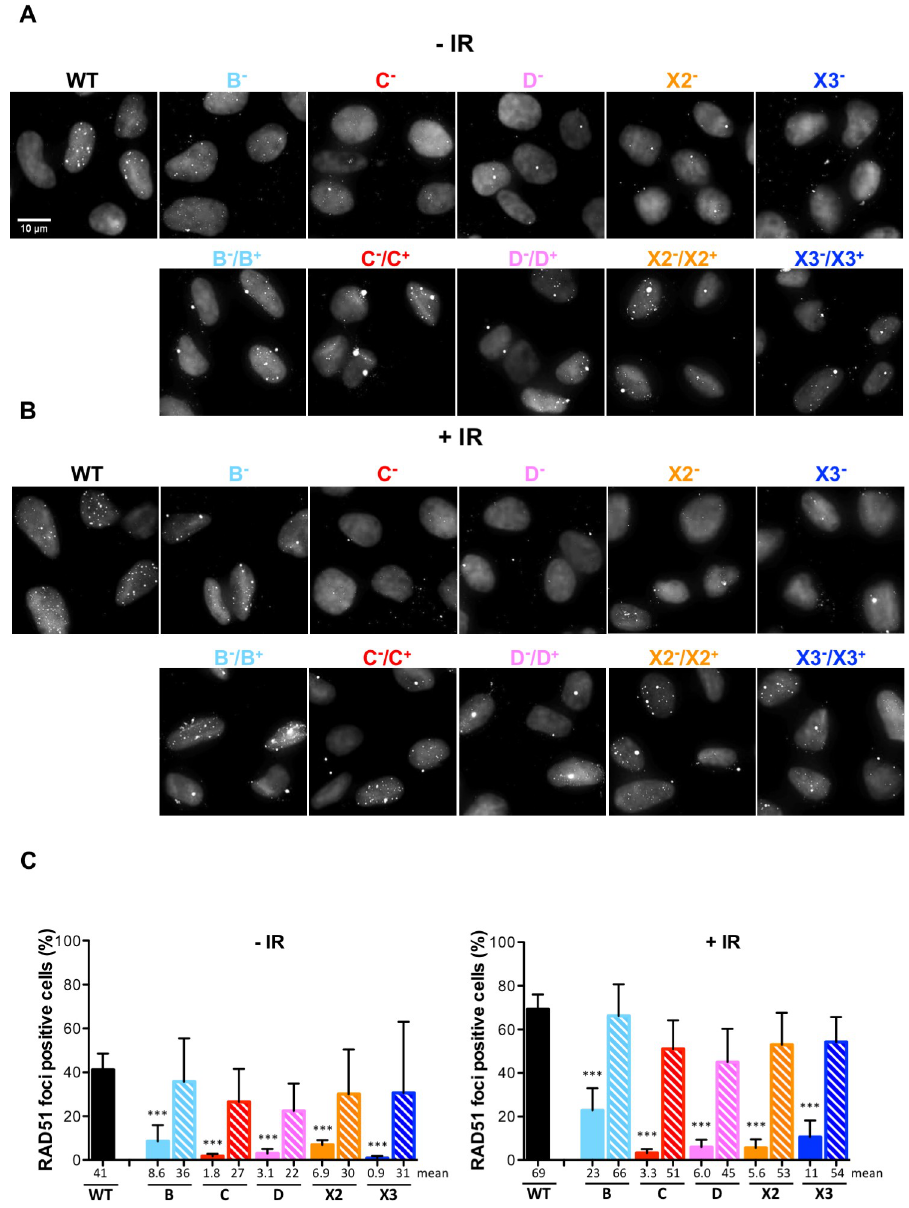
Fig 4. RAD51 nuclear focus formation is impaired in RAD51 paralog disrupted cells. (A, B) Detection by immunofluorescence of RAD51 nuclear foci in wild-type and RAD51 paralog disrupted U2OS cells, untreated (-IR) or 4 h after exposure to 4 Gy (+IR). Representative micrographs were obtained by confocal microscopy and shown as black and white overlays of RAD51 immuno-staining signal and DNA staining with DAPI to delineate nuclei. Top row panels are images obtained from wild-type and mutant cells. Bottom row panels are images obtained from the mutant lines stably complemented with a retroviral construct expressing the corresponding wild-type allele. Note that some RAD51 foci are detected outside of the nuclear region. These correspond to the accumulation of RAD51 at centrosomes (microtubule organizing centers) as verified by gamma-tubulin co-localization experiments. (C) Quantification of RAD51 nuclear focus formation by counting cells with at least 5 foci per nucleus as positive. For wild-type and mutant cells, in two experiments at least 100 nuclei were scored, and at least 50 nuclei were scored in the third experiment. For the stably complemented mutant cells at least 50 nuclei were scored in three experiments. Data are presented as means +/- SD from three independent experiments. See S5A Fig for the entire data pools. Differences between mutant and wild-type cells were statistically analyzed using unpaired one-way ANOVA and Tukey’s test. � p < 0.05, �� p < 0.01, ��� p < 0.001, ns not significant. Comparisons between complemented and wild-type cells were all ns in -IR and in +IR conditions (not indicated in the figure). Comparisons between complemented and mutant cells were all ns in -IR conditions; B �� , C ��� , D �� , X2 ��� and X3 �� in +IR conditions (not indicated in the figure).